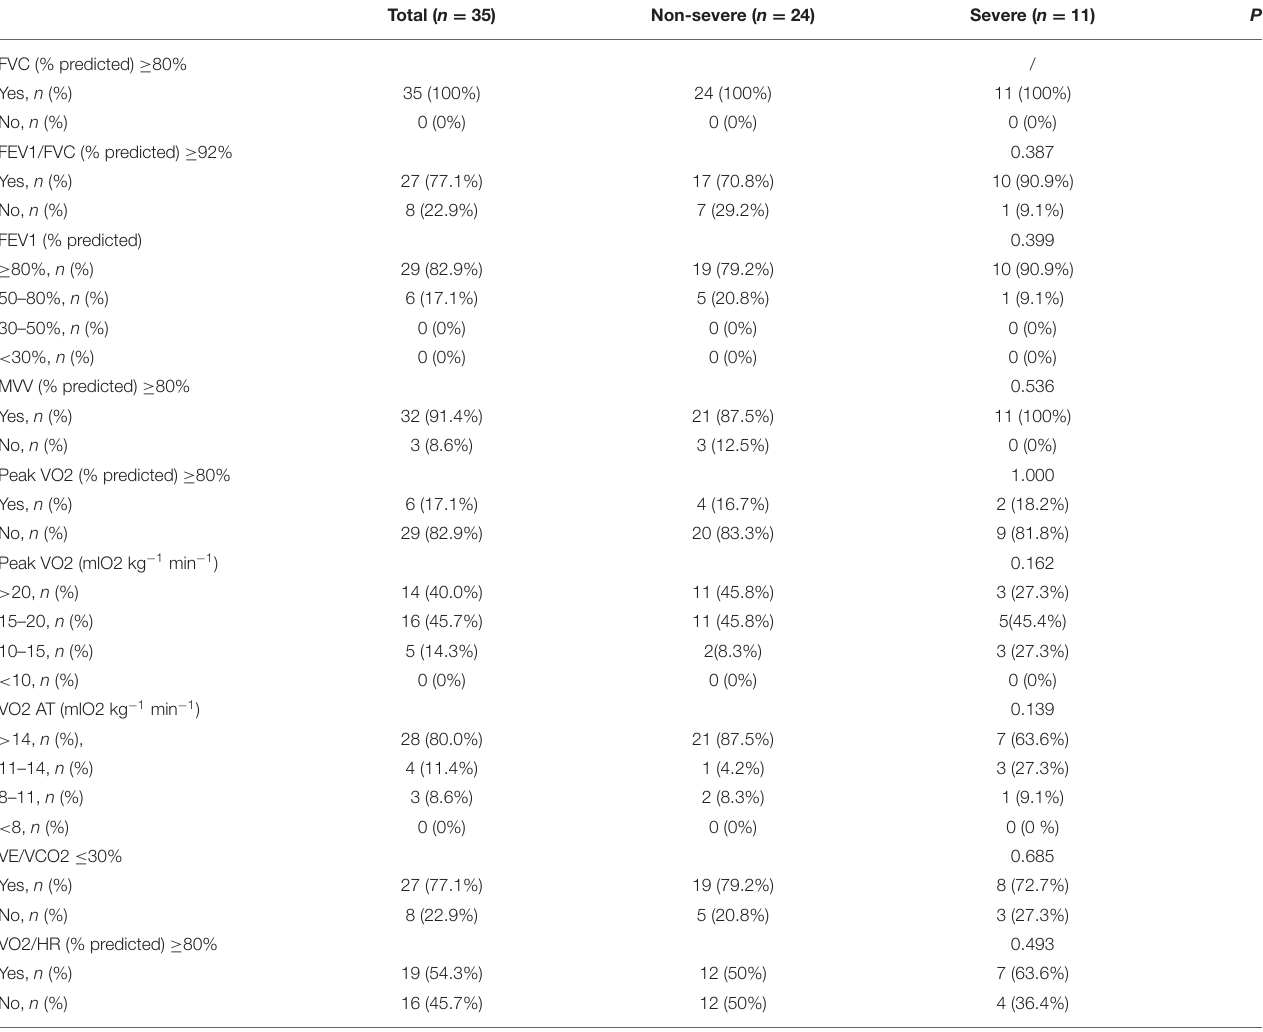
TABLE 2 | Result of CPET (Cardiopulmonary exercise